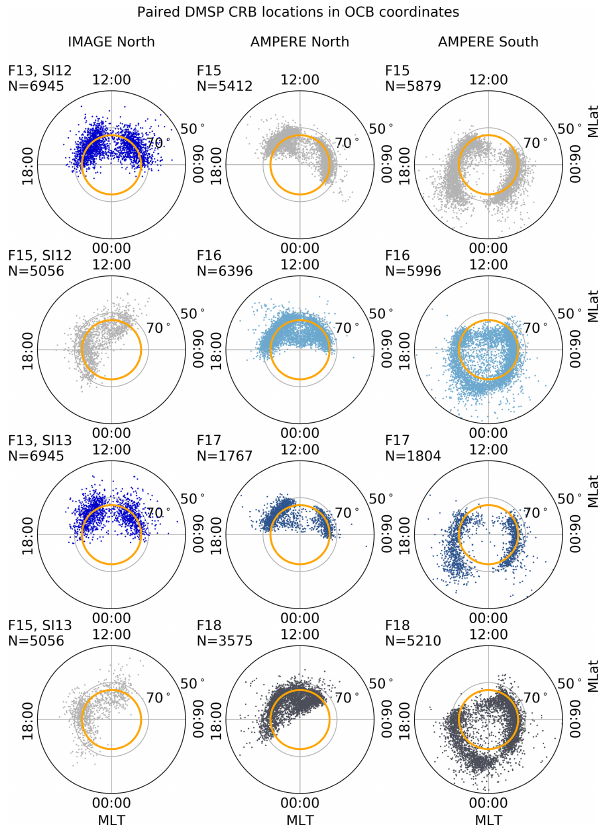
Figure 4. Paired IMAGE and AMPERE OCBs with DMSP CRBs for the available hemispheres and each satellite. The IMAGE data show the SI12 and SI13 observations for the Northern Hemisphere (left column), while the median elliptical correction was applied to obtain the AMPERE OCBs shown in the middle and right columns (which show the Northern Hemisphere and Southern Hemisphere respectively). The scattered points show the DMSP IVM CRBs, and the gold circle shows the IMAGE or AMPERE OCB. To simplify the comparison, the DMSP IVM CRB locations are plotted in ad- justed polar coordinates (Burrell and Chisham, 2018). Although all CRBs paired with IMAGE or AMPERE OCBs are shown here, only CRBs within 1h of 06:00 or 18:00MLT were used in this